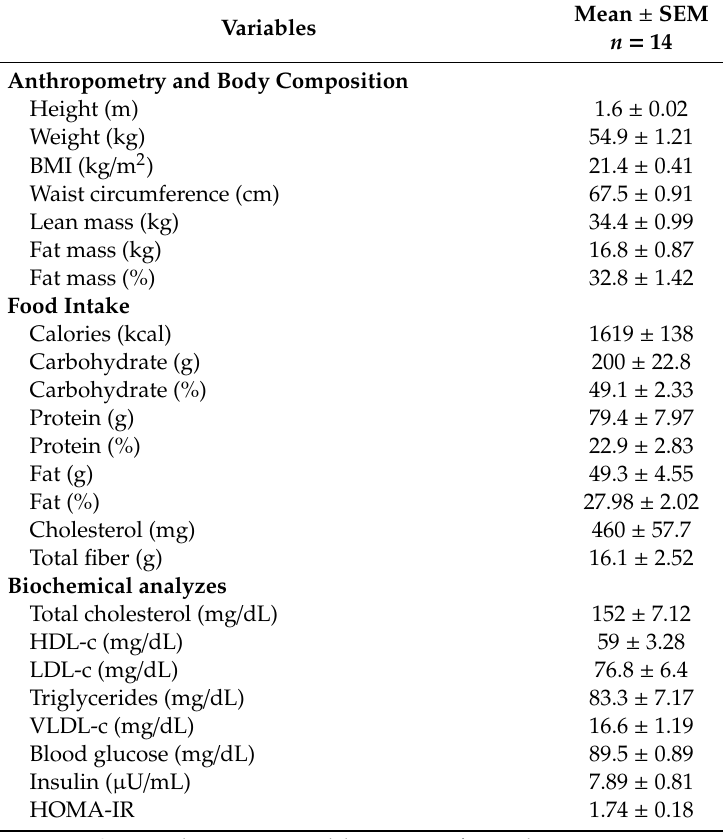
Table 1. Baseline characteristics of